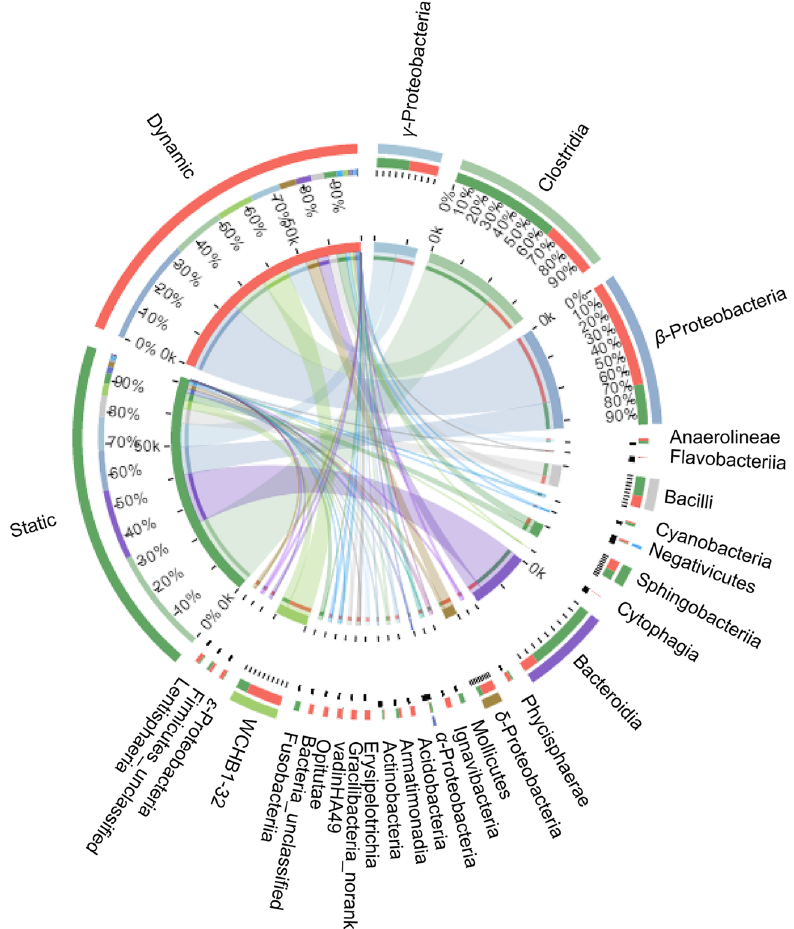
Figure 4. The relation between samples and the bacteria at the class